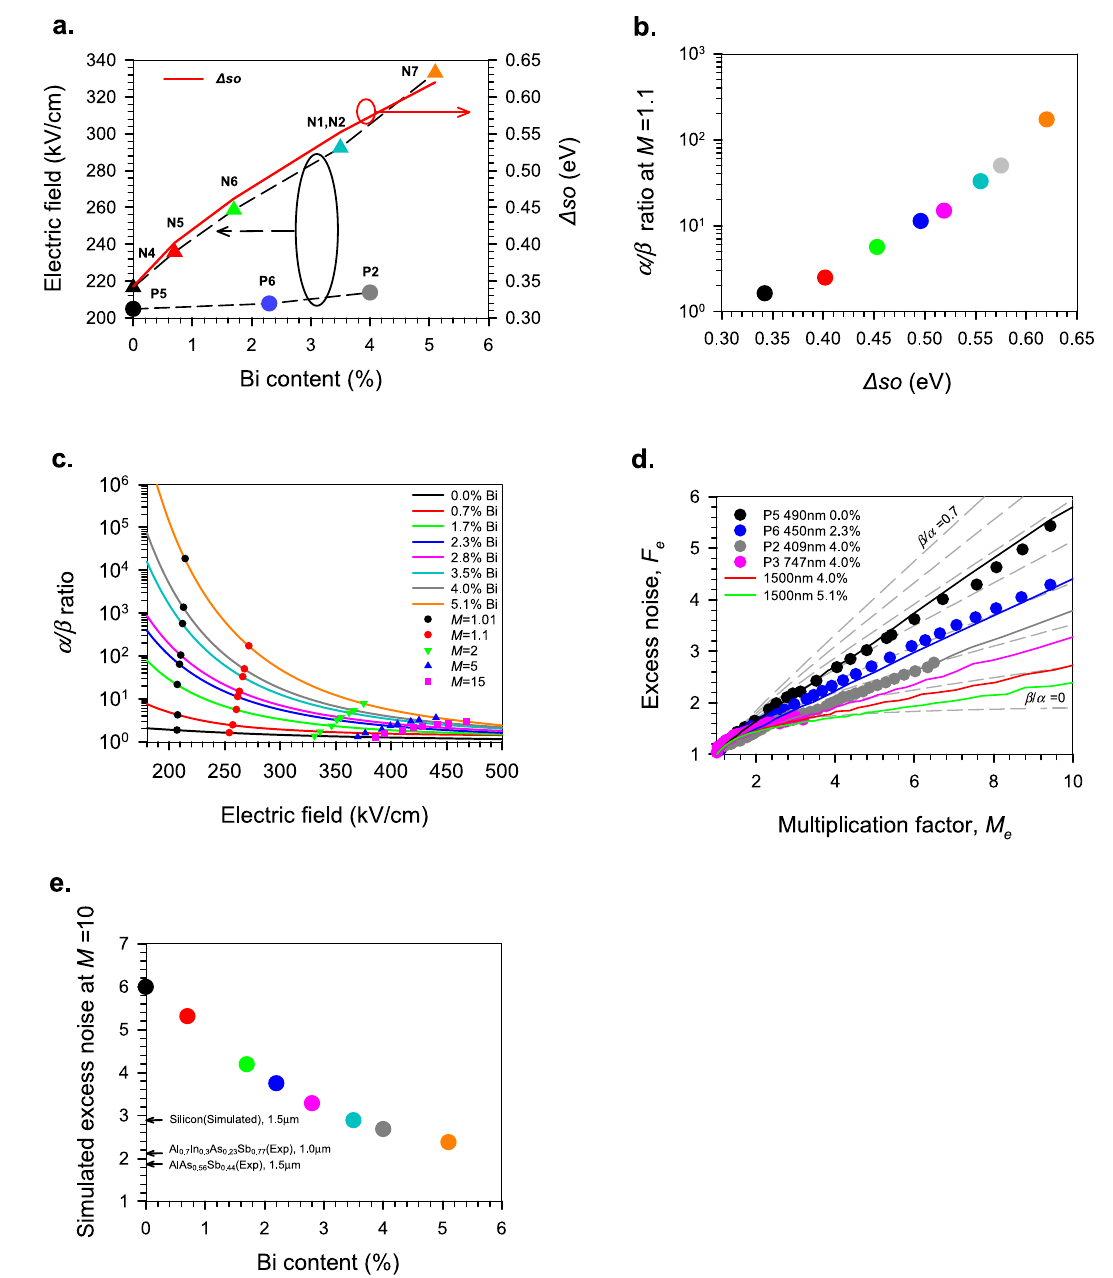
Fig. 3 Effect of Bi on the α / β ratio of GaAs. a The minimum electric fi eld required to cause electrons and holes to ionize (de fi ned as when M e , h = 1.01) in nominally 400nm GaAsBi p-i-ns and n-i-ps. The Δ so energy vs Bi content is also shown. b The α / β ratio (at M e = 1.1) in GaAsBi as a function of the Δ so energy. c The calculated electric fi eld dependence of the α / β ratio for different Bi contents. The symbols highlight the calculated α / β ratio at M e values of 1.01, 1.1, 2, 5, and 15 in 400nm GaAsBi p-i-n diodes. d The measured excess noise, F e (symbols), in the nominally 400nm and 800nm thick p-i-n diodes with 4 % Bi, showing how adding Bi reduces the excess noise of GaAs. The solid lines are simulations that show good agreement with the measurements and predict that much lower excess noise is possible for 1500nm thick structures with 4 % (red line) and 5.1 % (green line) Bi. The dashed lines represent the theoretical noise predictions by McIntyre 3 for β / α ratios from 0 to 0.7 in steps of 0.1. e The simulated excess noise ( F e ) at M = 10 for 1500nm thick avalanching structures with increasing Bi content. Also shown are the best reports for AlAsSb 40 and AlInAsSb 41 , and simulations for silicon using data from Overstraeten and Man 5 Fig. 3d show that a 1500 nm p-i-n with 5.1 % Bi should have an of α and β from Fig. 2e, f to determine the avalanche multi- α / β ratio of 20. Fig. 3e shows how the excess noise due to electron plication excess noise. Implementing this model and using values multiplication at a M of 10 in 1500 nm thick avalanching of E t he = 2.3 eV and E t hh = 2.1 eV 39 gave good agreement with the measured excess noise not only for the GaAs structure, but also structures is expected to decrease rapidly with increasing Bi% if for the 2.3 % Bi and 4.0 % Bi structures as shown by the coloured the issue of high dark currents could be mitigated. This fi gure lines in Fig. 3d. Operating at lower electric fi elds (via thicker shows that while equivalent thickness Sb containing structures avalanching region widths) or with higher Bi contents should give still have slightly lower excess noise 40,41 , with the addition of more signi fi cant excess noise reductions, and simulations in just 3.5 % Bi to GaAs we expect the excess noise to be